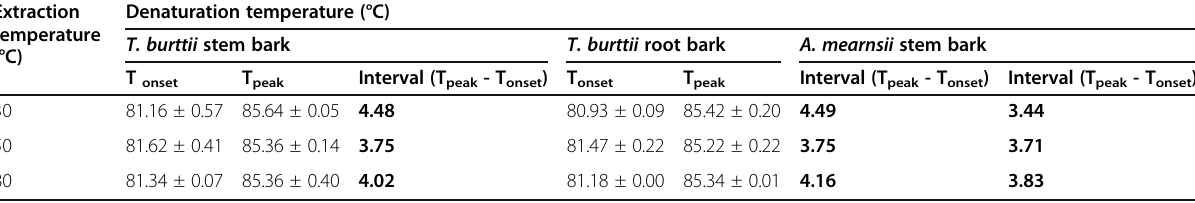
Table 1 The interval between T onset and T peak of hide powder cross-linked with extract of Tessmannia burttii and Acacia mearnsii at pH 5 in dependence of Temperature of extraction Extraction